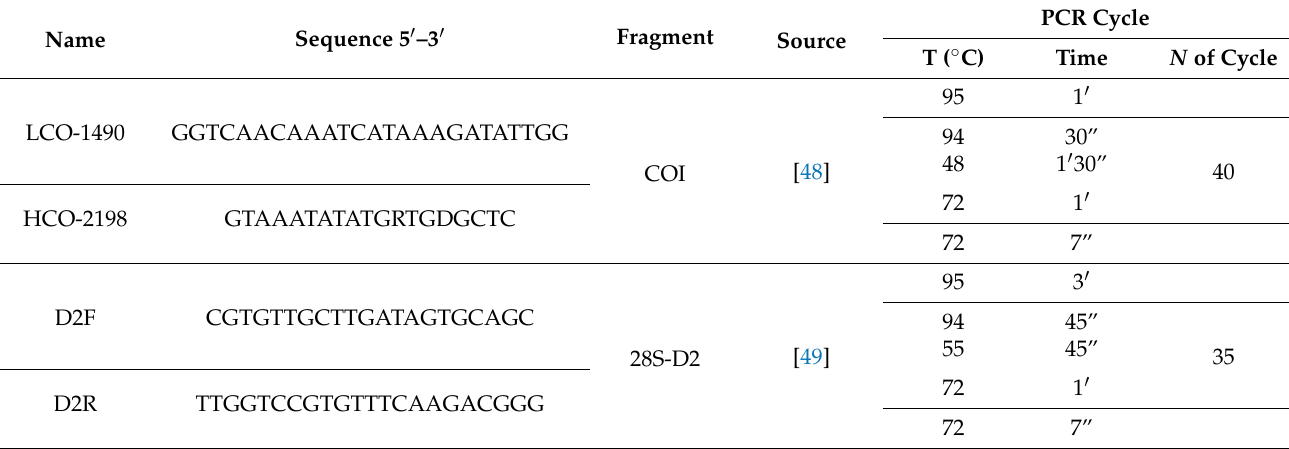
Table 2. Primer sequences with the relative amplification program of the mitochondrial cytochrome c oxidase subunit I (COI) and the expansion segment D2 of the 28S ribosomal subunit (28S-D2) genetic regions for molecular characterization of insect